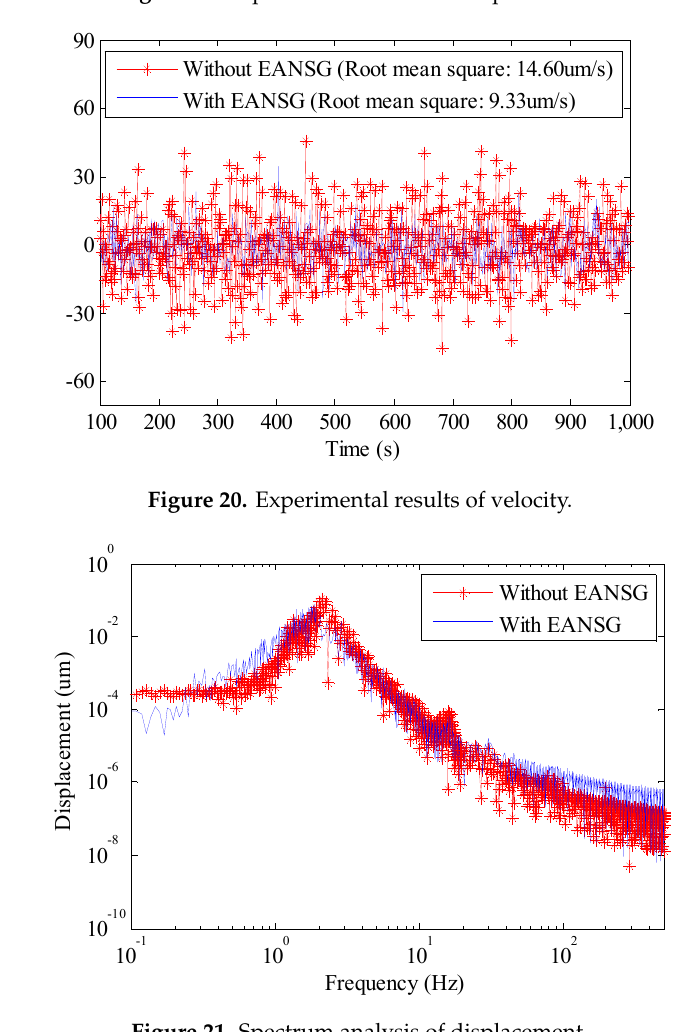
Figure 22. Spectrum analysis of velocity. 5. Conclusions An EANSG method was proposed to reduce the natural frequency of an optical platform and improve its low-frequency vibration isolation performance. Nano-resolution laser interferometry sensors were proposed and developed to monitor and feedback the micro-vibration of the optical platform, and precision electromagnetic actuators were developed to counteract the positive stiffness of pneumatic springs by actively generating negative-stiffness using a relative displacement feedback strategy. The principle and design of the EANSG are detailed as presented, and the effectiveness of the method was validated by experiments. The spectrum analysis of the impact response experimental results indicate that the natural frequency of the optical platform decreased from 2.00 to 1.37 Hz. The time domain displacement and velocity experimental results indicate that the of vibration displacement decreased from 1.28 to 0.69 μ m, the root mean square of the vibration velocity decreased from 14.60 to 9.33 μ m/s. Therefore, it can be concluded that the proposed method can effectively enhance the low-frequency vibration isolation performance of optical platforms, and can be applied in the fields requiring better low-frequency vibration isolation performance, such as advanced manufacturing, cutting-edge scientific research. Our future work will focus on the nonlinear feedback control of EANSG. Author Contributions: Conceptualization, Y.Z. and J.C.; funding acquisition, J.C.; methodology, Y.Z. and J.C.; project administration, J.C. and L.Z.; software, Y.Z. and J.Z.; validation, J.Z., X.B.; writing—original draft, Y.Z. All authors have read and agreed to the published version of the manuscript.